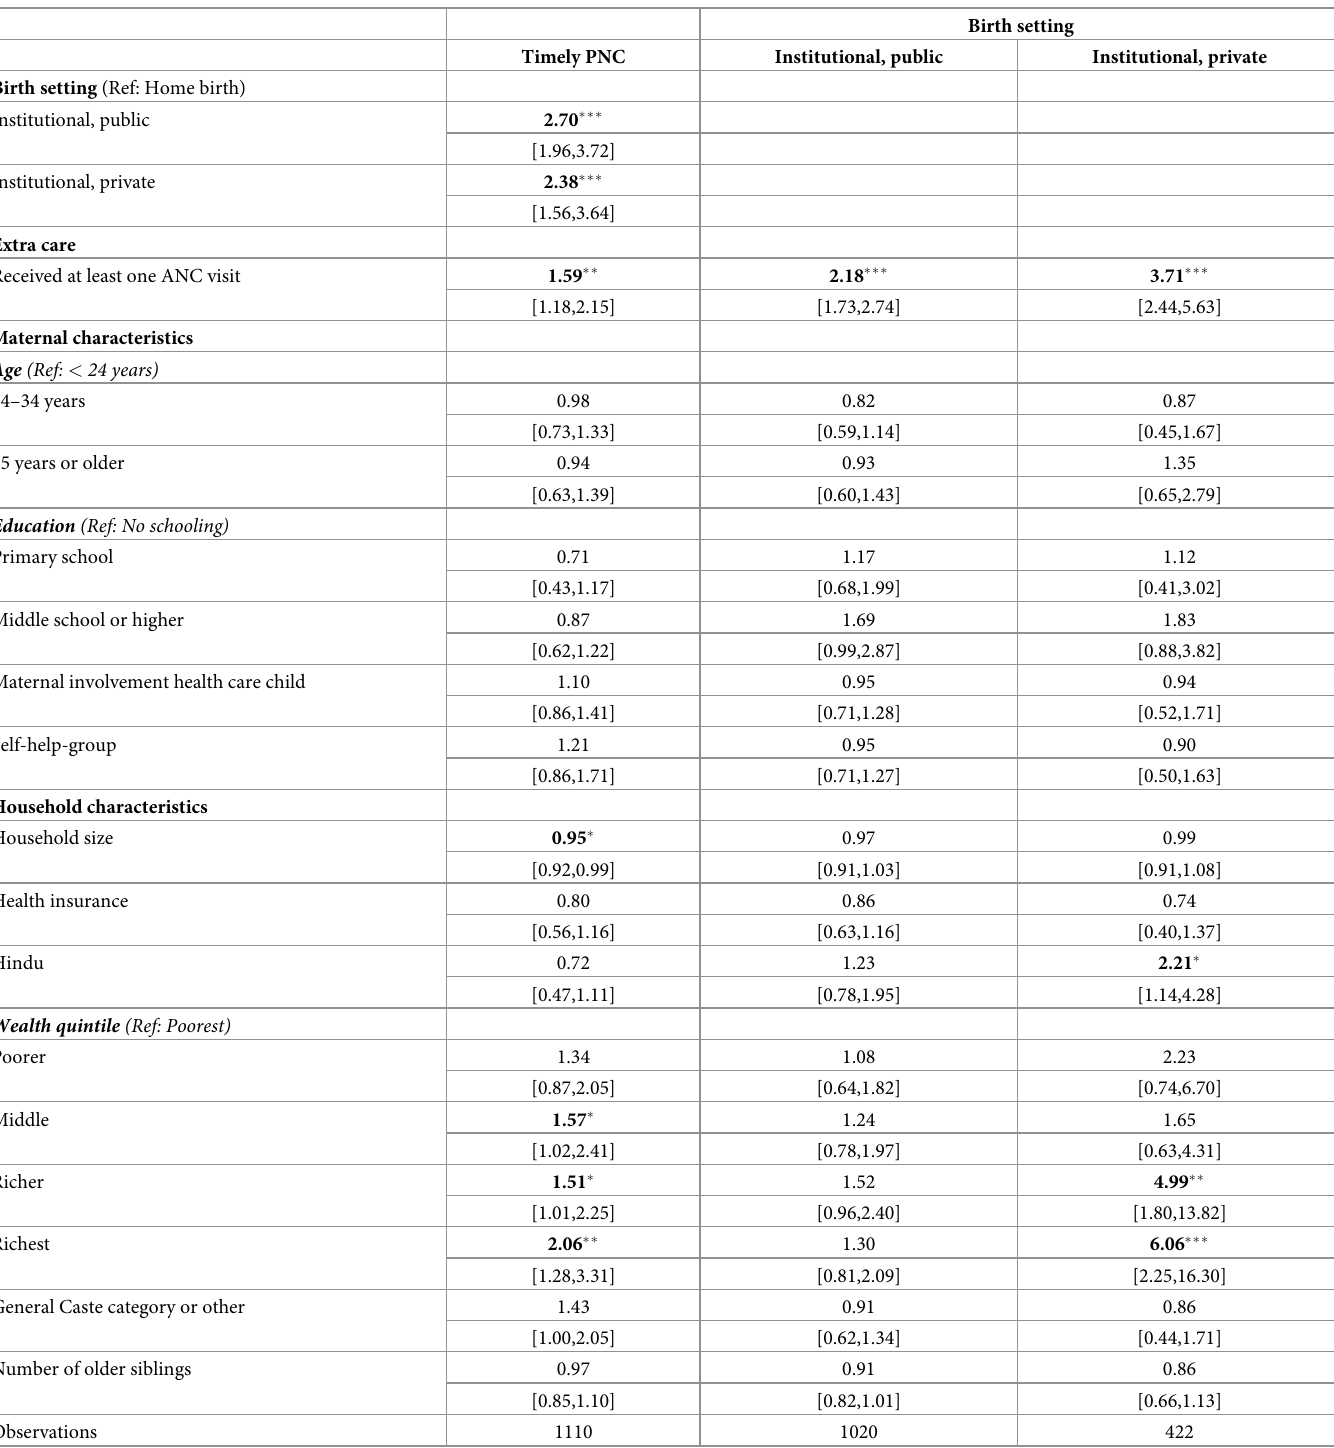
Table 5. Predictors of perinatal health care uptake.